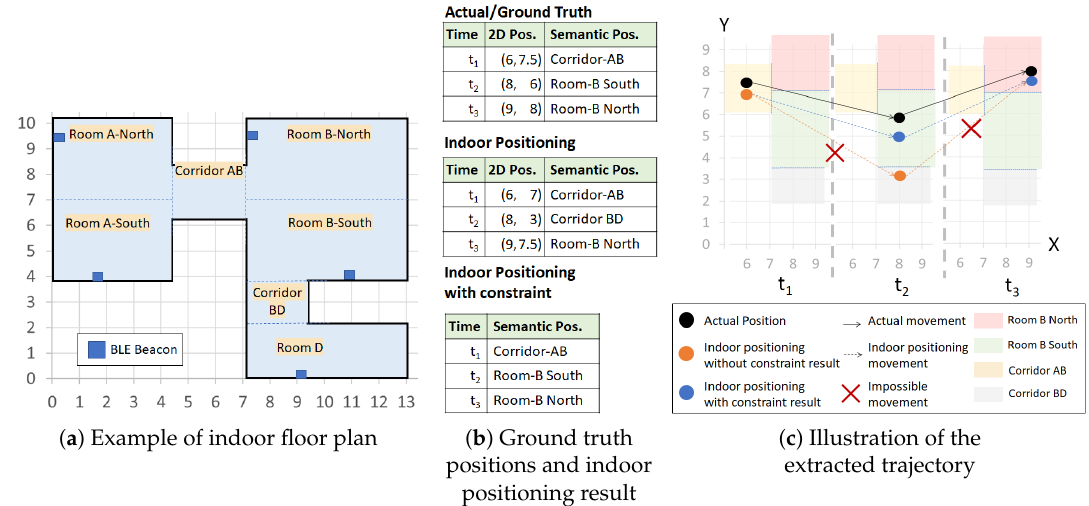
Figure 1. Example of indoor positioning and trajectory